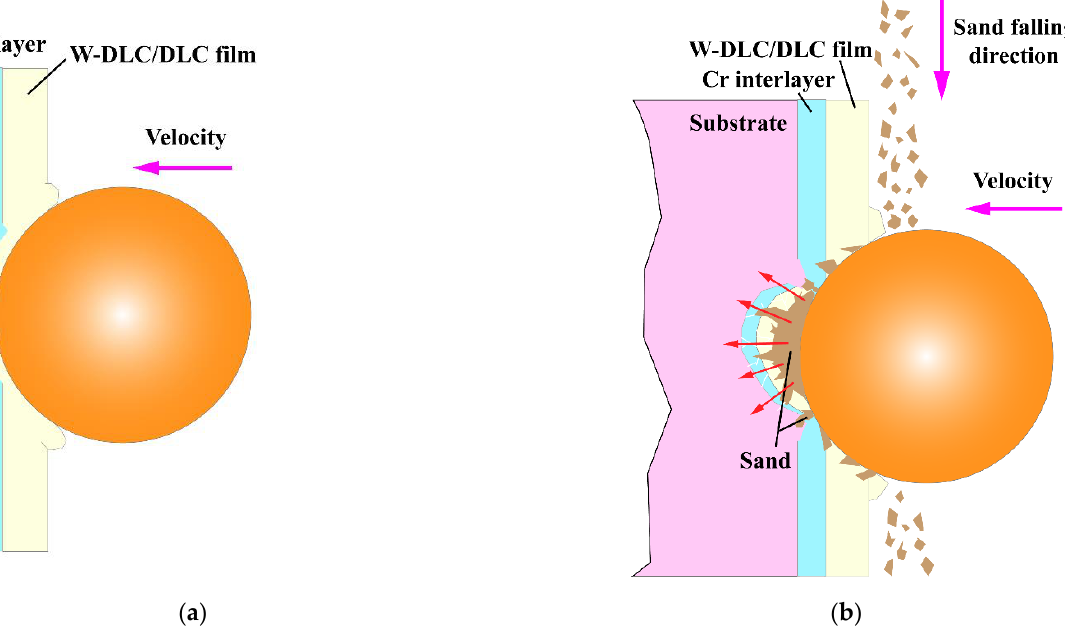
Figure 11. Wear scar topography and elemental distribution of Cr/W-DLC/DLC multilayer films at 500 °C under the sand condition: ( a – c ) wear scar topography; ( d ) elemental distribution. Table 2. Chemical composition at typical position of wear scar (wt. %).